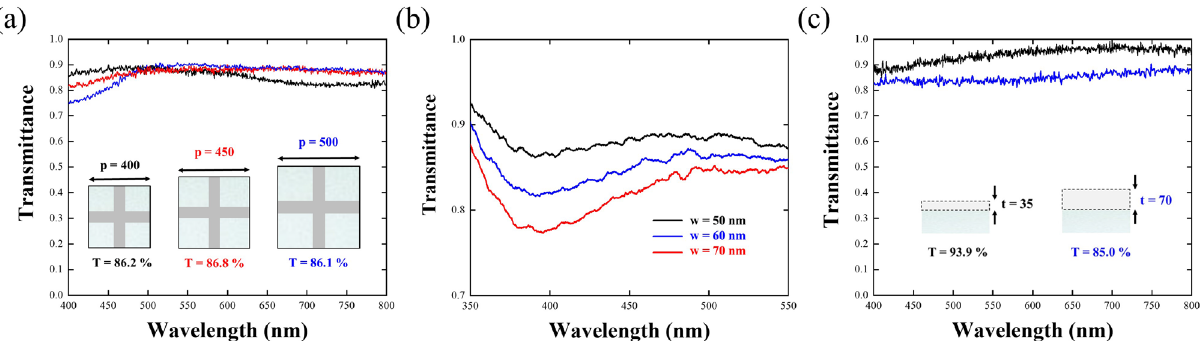
Figure 6. ( a ) Measured transmittance of Ag NPWs with periodicities of 400, 450, and 500 nm and fixed linewidth of 50 nm and thickness of 70 nm. ( b ) Increasing the linewidth (i.e., from 50 to 70 nm) of NPWs with p = 400 results in a red-shift of LSPR, experimentally corroborating the simulated results. ( c ) Measured transmittance of 35- and 70-nm-thick ITOs.